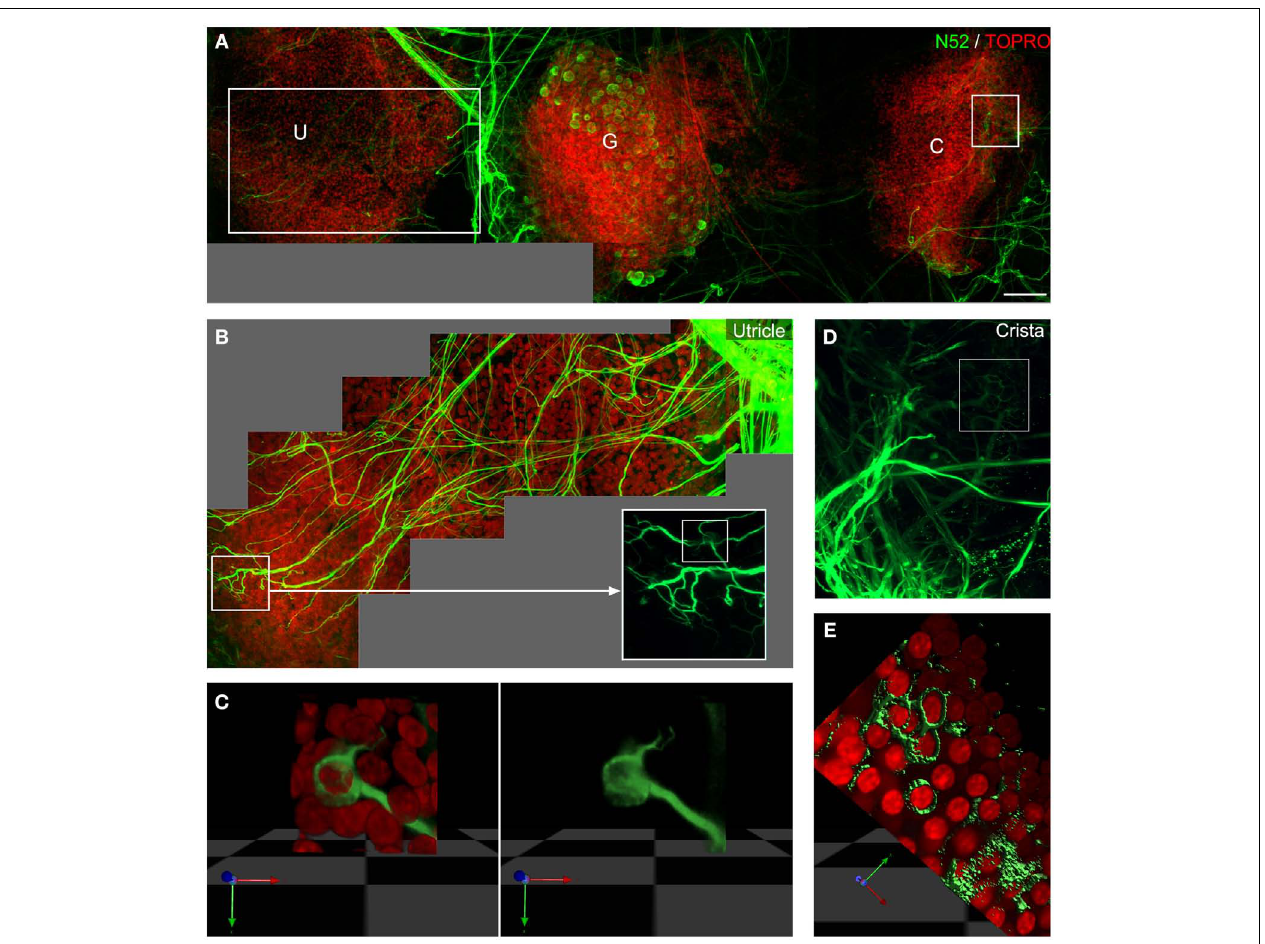
detailed observation [inset, (B) ] on nerve endings reconstructed in 3D (C) showed the additional formation of calyceal innervations in utricles. In cristae, PMA increased the number of neurites entering the sensory epithelia (D) , and the number of calyces as shown in the 3D reconstruction (E) . Neurofilaments stained in green and nuclei in red. Scale bar 100 μ m (A)